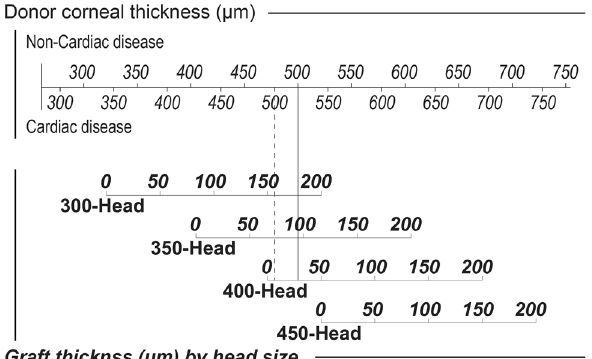
Figure 2. A nomogram to predict the post-cut central graft thickness for a mechanical microkeratome cutting with an artificial chamber pressurizer and one use-plus automated. For example, the central graft thickness of a 500-μm cornea from a donor with non-cardiac disease (solid line) is predicted to be 180.1 μm, 96.1 μm, and 36.5 μm for a cut using 300-, 350-, and 400-head sizes, respectively. The thickness for donors with cardiac disease as the cause of death (dashed line) is predicted to be 159.4 μm, 75.5 μm, and 15.8 μm for a cut using 300-, 350-, and 400-head sizes, respectively.